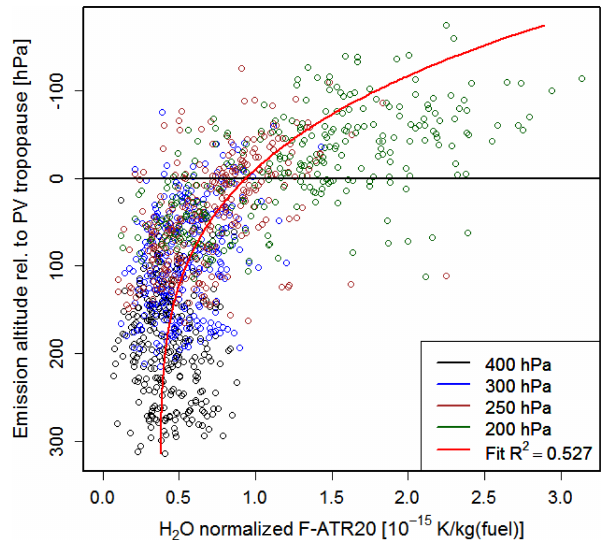
Figure 15. Correlation of water vapour climate change functions (kelvin (K) per kilogram of fuel) with emission altitude difference relative to the actual tropopause. Pressure levels of the various emis- sion altitudes are distinguished by different colours. A fit function is indicated by the red